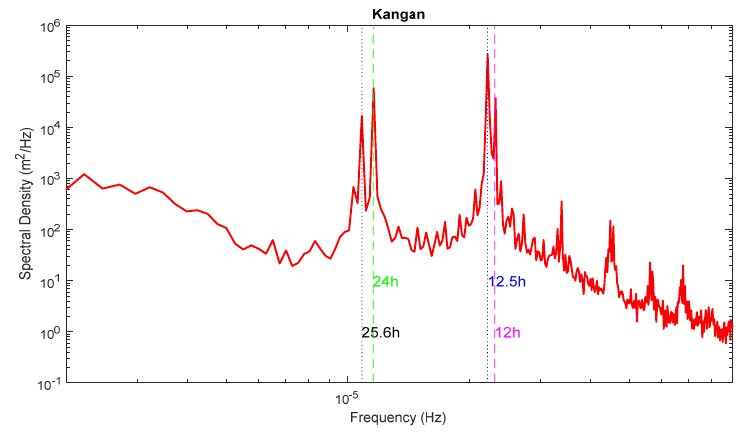
Figure 6. Energy spectrum of sea level at Kangan station.